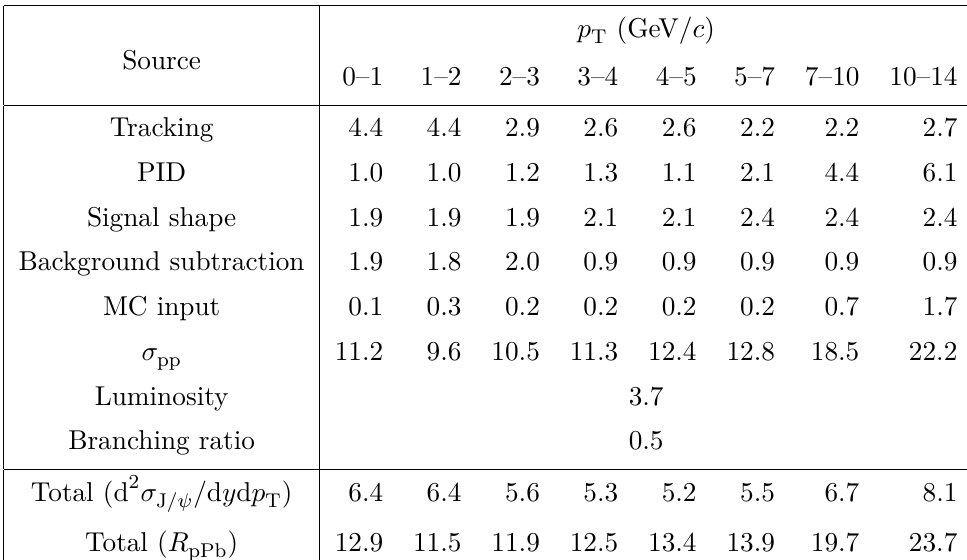
Table 1 . Summary of the systematic uncertainties, in percentage, of the inclusive J /ψ cross section d 2 σ / d y d p and nuclear modification factor R J /ψ T